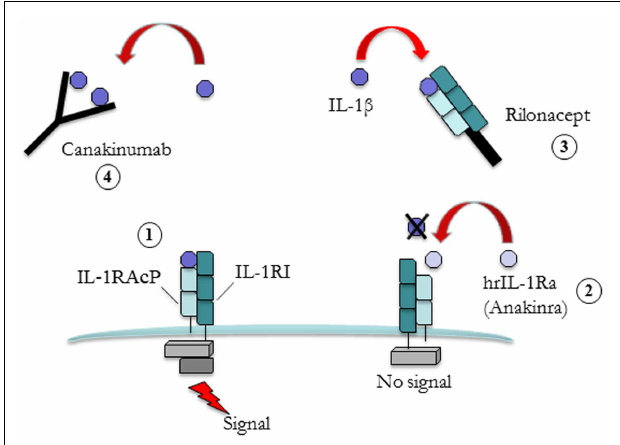
FIGURE 1 | Different strategies for IL-1 blockade. Free interleukin (IL)-1b binds to type 1 IL-1 receptor (IL-1R1) and to the adaptor protein IL-1RAcP leads to signal transduction (1) . Human recombinant IL-1 receptor antagonist (hrIL-1Ra, Anakinra) (2) competes with free IL-1 β for the binding with IL-1R1 but not with the adaptor protein, thus preventing signal transduction. Rilonacept (3) is a fusion protein comprising the extracellular domains of the IL-1 β receptor (IL-1RI) and adaptor protein (IL-1RAcP) attached to a human IgG molecule. Its action is to bind to circulating IL-1 β . The same mechanism of action is also valid for Canakinumab (4), a fully humanized anti-IL-1 monoclonal